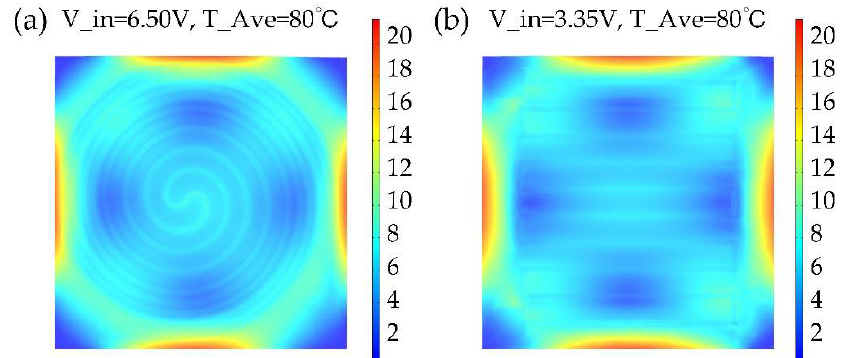
Figure 5. The internal thermal stress distribution of ( a ) Circular-shaped structure, and ( b ) S-shaped structure with the same steady-state average temperature of 80 °C.